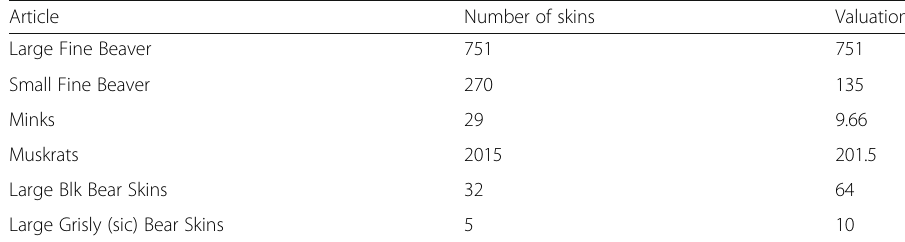
Table 2 Valuation of goods traded for at Ft. St. James, 1822, partial list (Source: Morton,